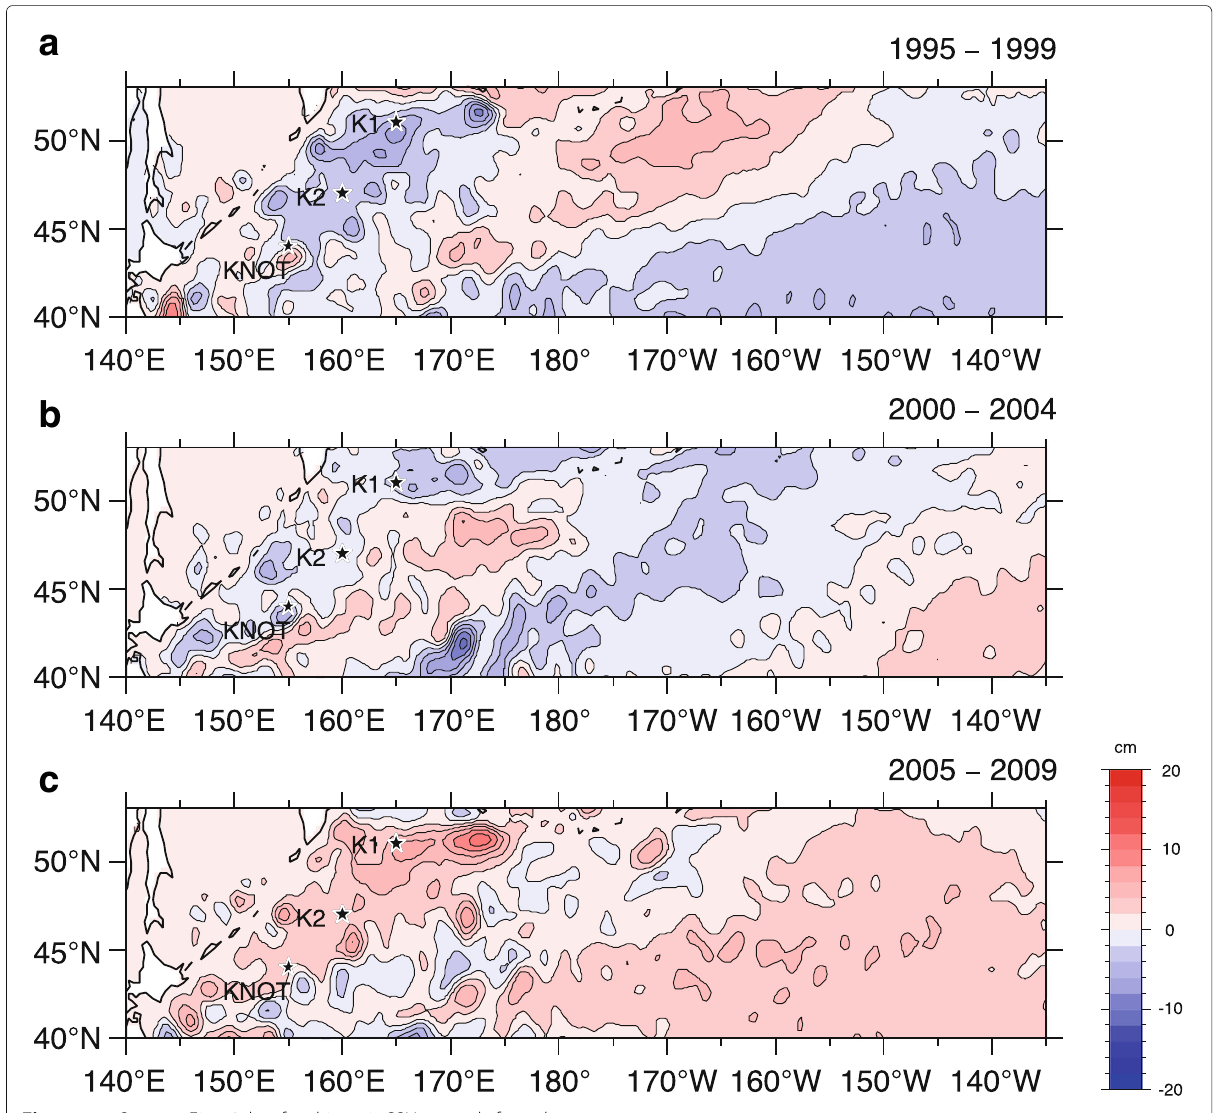
Fig. 14 a – c Same as Fig. 13, but for altimetric SSH anomaly from the mean state